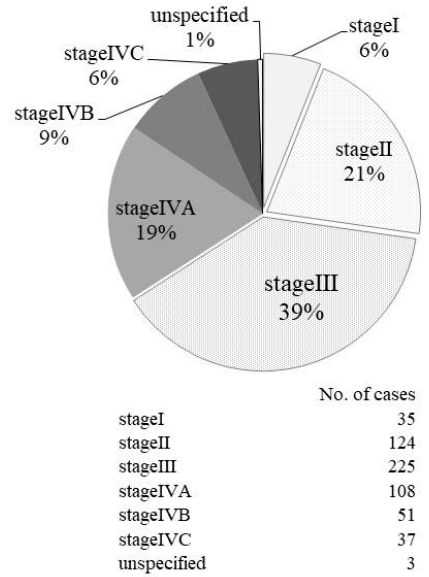
Figure 4. Pretherapy clinical staging. Patient staging distribution according to the TNM classification of UICC 7th Edition.